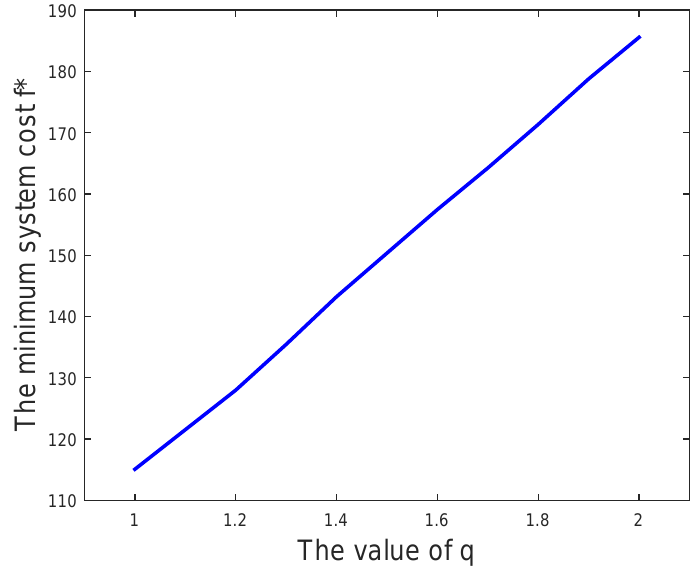
Figure 7. The trend of the system’s minimum cost while the value of q